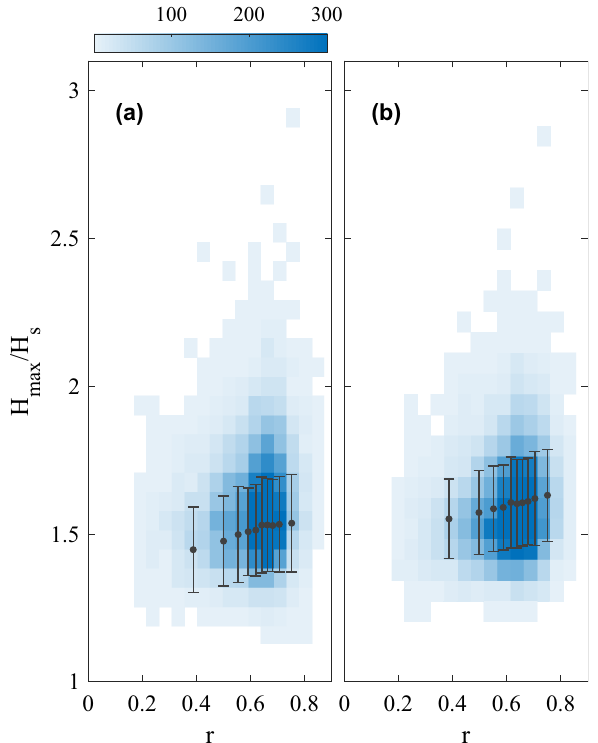
Figure 3. Maximum non-dimensional wave height H / H s within 30 min, as function of crest-trough correlation r . Individual data are shown as blue scatter plot, with data density given by the colour bar, and constant-size 1 σ are shown in black. H bin averages and max , H s , and r are taken from ( a ) observations, ( b ) Monte-Carlo ±